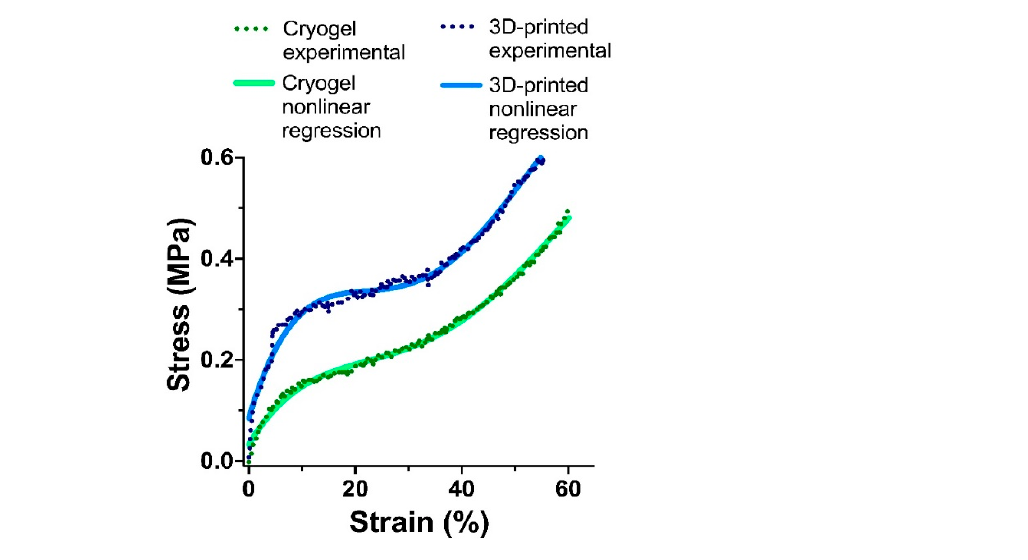
Figure 12. Strain–stress test curves for cryogelated and 3D-printed matrices. The compression stress was applied with initial force 0.1 N. The speed of compression was 2 mm/min. The data on the graph are representative of 3 measurements ( n = 3).